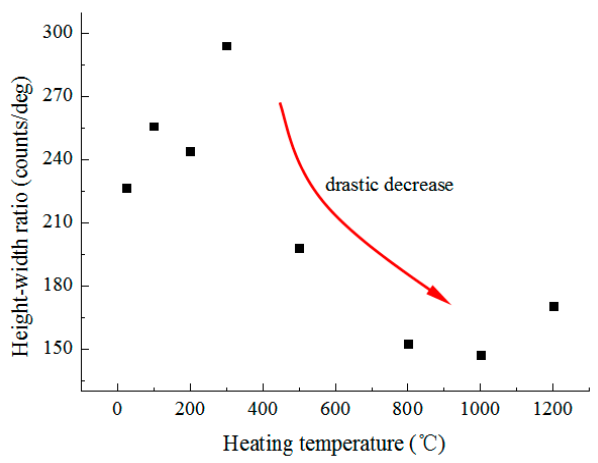
ff raction peak of feldspar with Figure 6. The height–width ratio of the diffraction peak of feldspar with temperature. Figure 6. The height–width ratio of the di